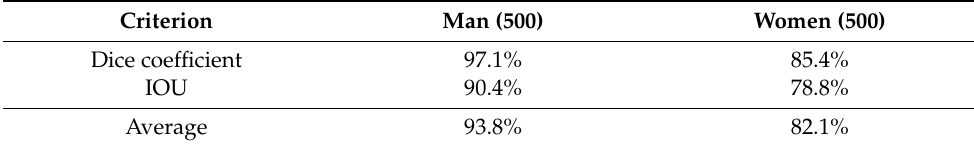
Table 6. Accuracy of gender hair